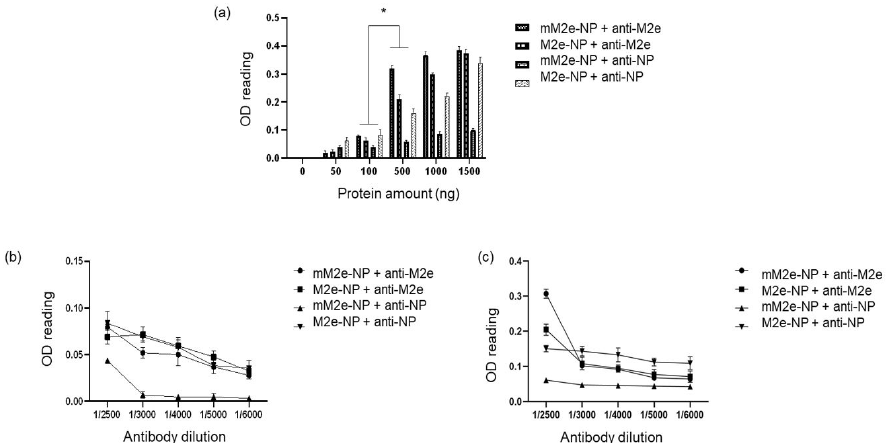
Figure 7. Testing the antigenicity of M2e-NP and mM2e-NP with ELISA. ( a ) The test was performed using 50–1500 ng proteins. The test was also performed using fixed amounts of proteins, i.e., ( b ) 100 ng and ( c ) 500 ng. The experiment was performed in triplicate ( n = 3), the data were presented as mean ± SD. * indicates p <